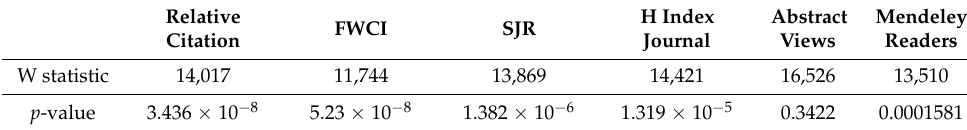
Table 2. Comparison of research impact using the Wilcoxon Mann–Whitney